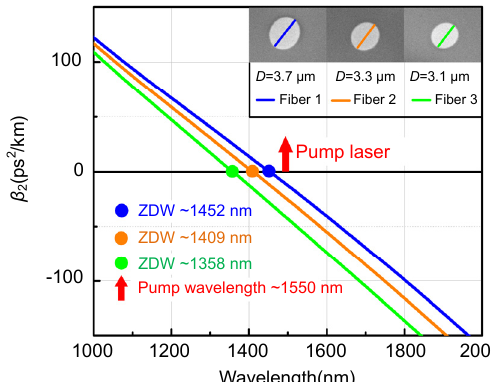
Fig. 6 | The calculated dispersions of the fibers with different sizes. Insets, scanning electron microscope images of the fibers with the diameters of 3.7 μ m, 3.3 μ m and 3.1 μ m, respectively.